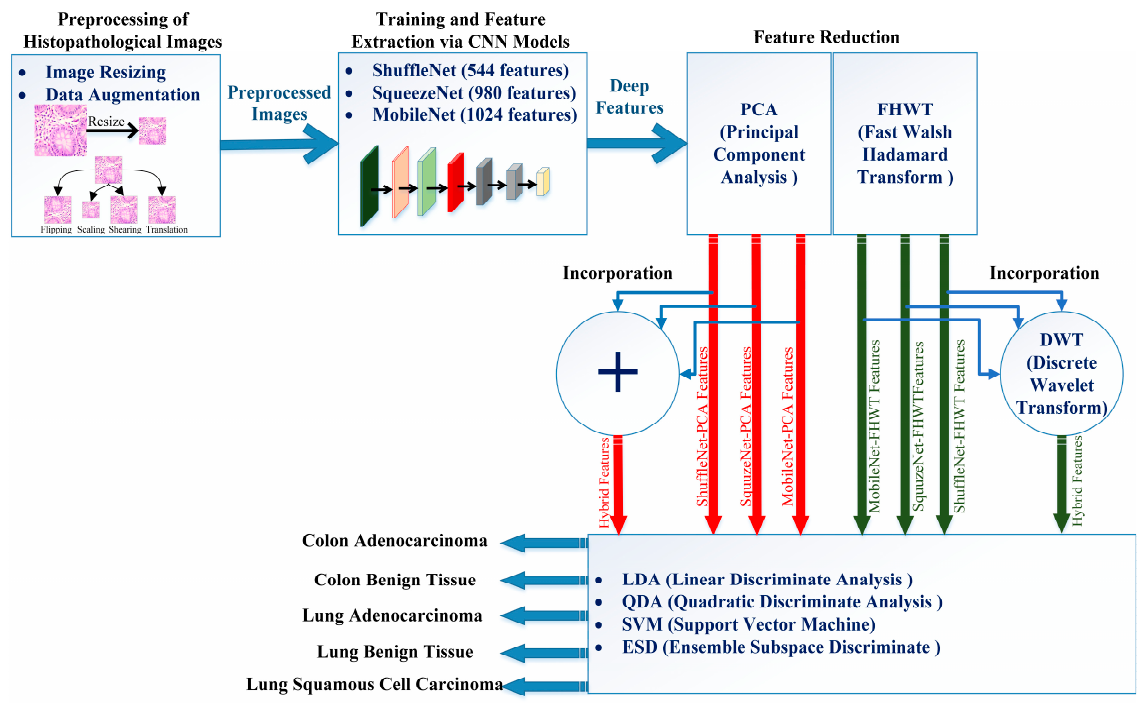
Figure 2. Stages of the proposed